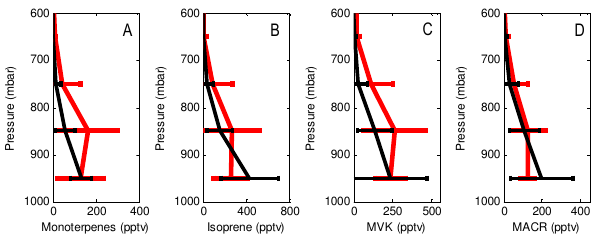
Fig. 3. Same as Fig. 2 but for (a) monoterpenes (only α - and β - Figure 3 Same as Fig. 2 for a) monoterpenes (only α - and β -pinene were measured during 2 pinene were measured during ARCTAS), (b) isoprene, (c) methyl ARCTAS), b) isoprene, c) methyl vinyl ketone, and d) methacrolein. 3 vinyl ketone, and (d) methacrolein. The apparent maximum in the ARCTAS profiles (red) at 800–900mbar is due to the plume high in biogenics sampled during flight #20 at 21:51 to 22:28UTC. If this plume is removed, both the model and the measurements show a smoothly decreasing profile with increasing altitude, as expected for reactive species with surface